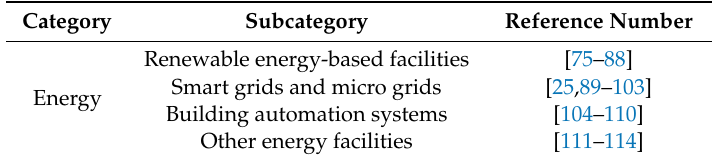
Table 3. Publications in the category of energy.